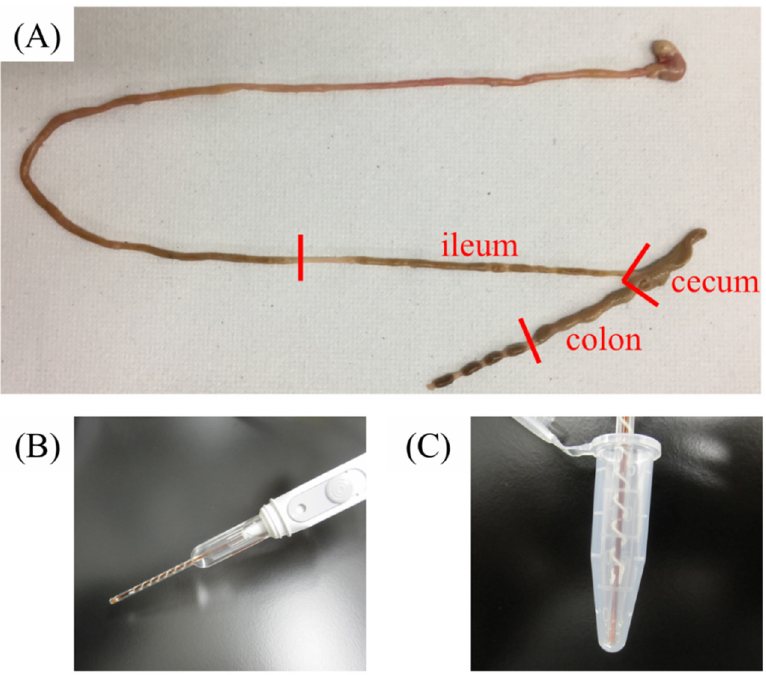
Figure 1. Sample collection and pH measurement. ( A ) Gastrointestinal tract of the control mouse. Samples were collected from three parts (ileum, cecum, and colon) of the gut of the mouse. ( B ) Micro ToupH electrode. ( C ) Electrode with a microtube that can measure a minimum volume of 50 μ L.